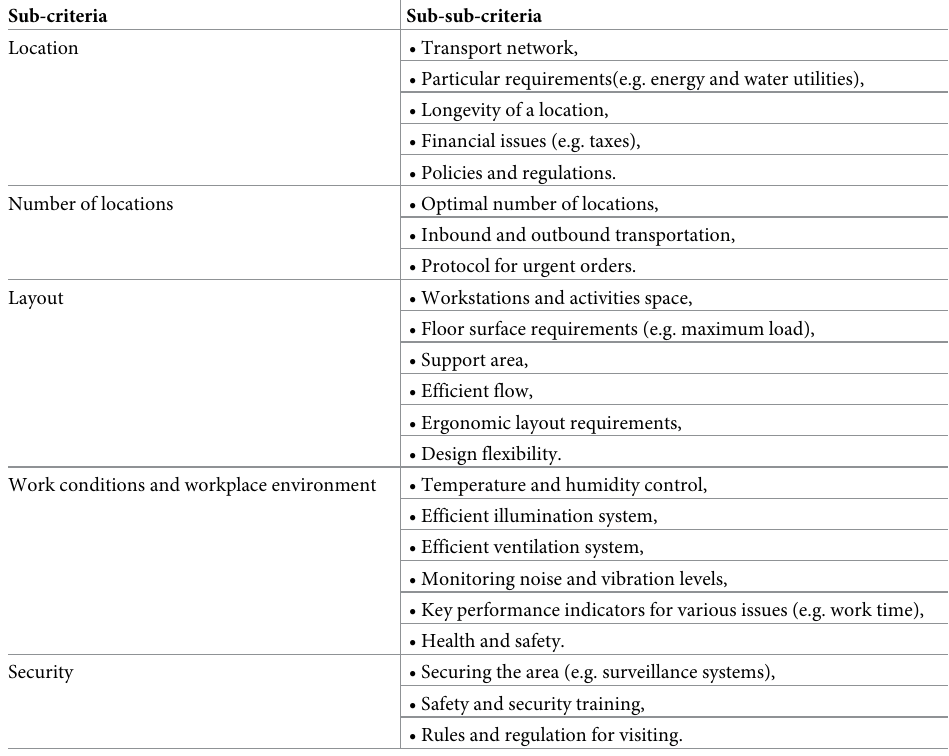
Table 1. The defined sub-criteria and the coreesponding sub-sub-criteria for the